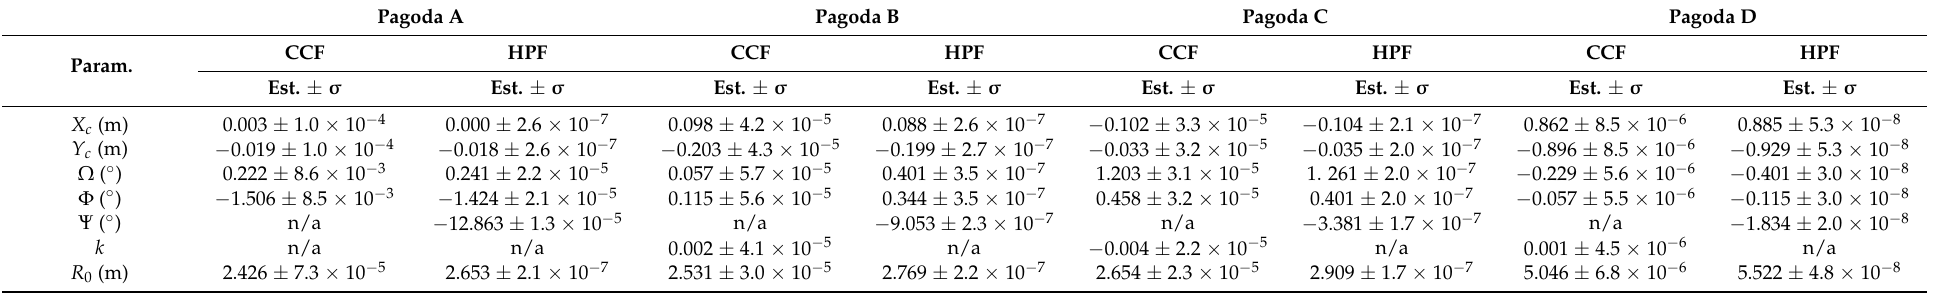
Table 4. Estimated parameters and their precisions of the CCF and the HPF for Part